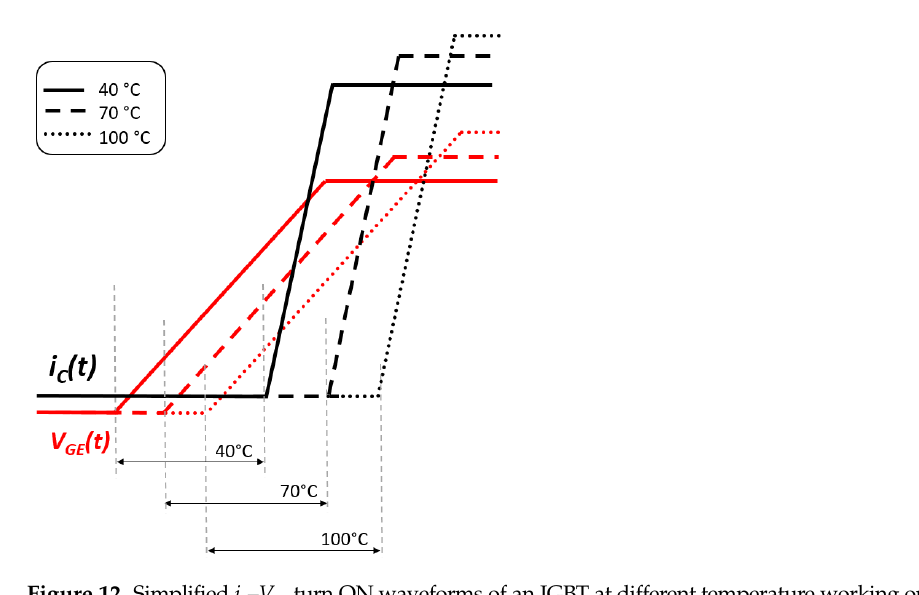
Figure 12. Simplified i c – V ge turn ON waveforms of an IGBT at different temperature working oper- ations.